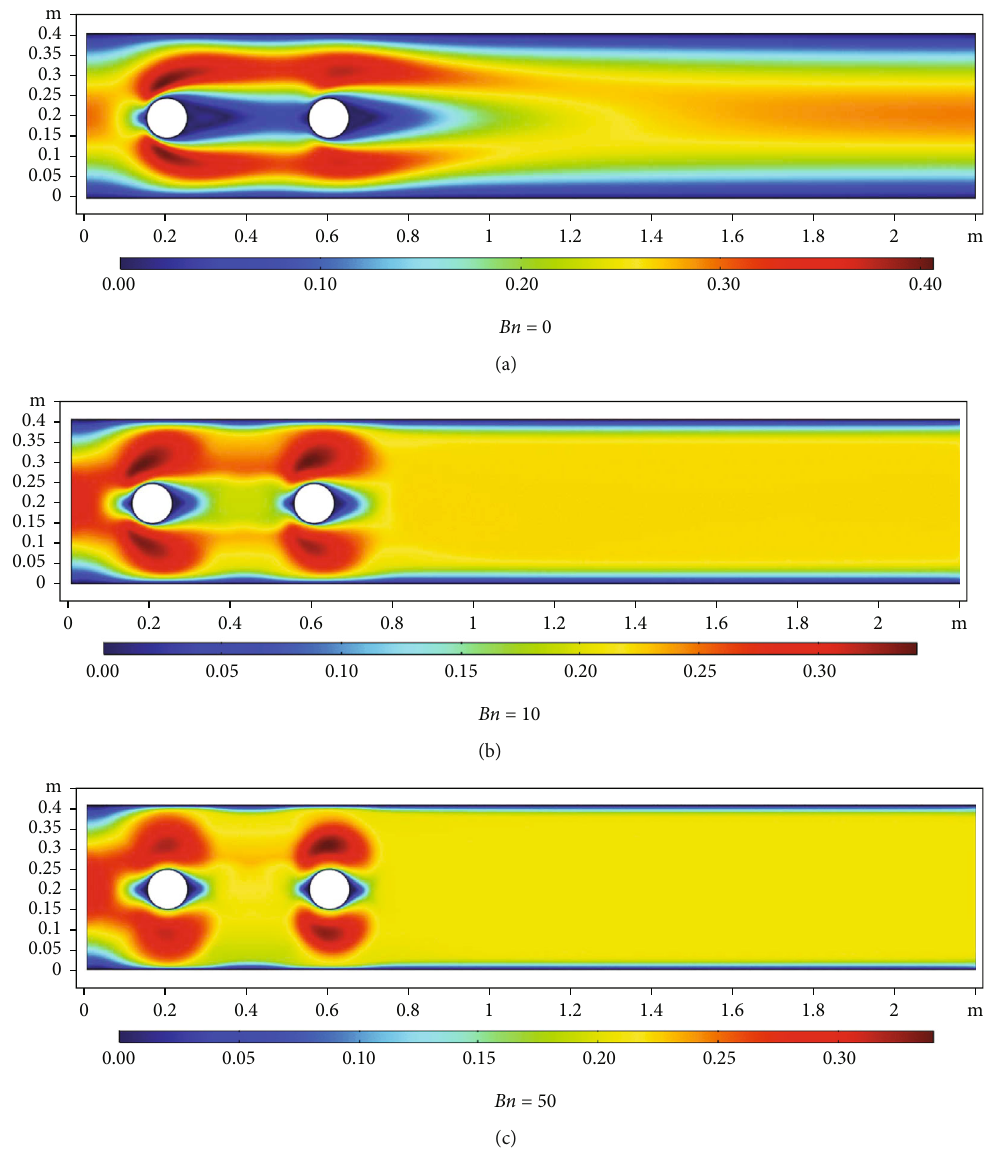
= 0 : 3 and Re = 20 . (a) Bn = 0 . (b) Bn = 10 . (c) Bn = 50 p